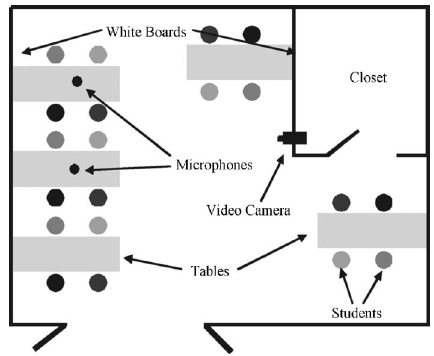
FIG. 7. Top view of the layout of the